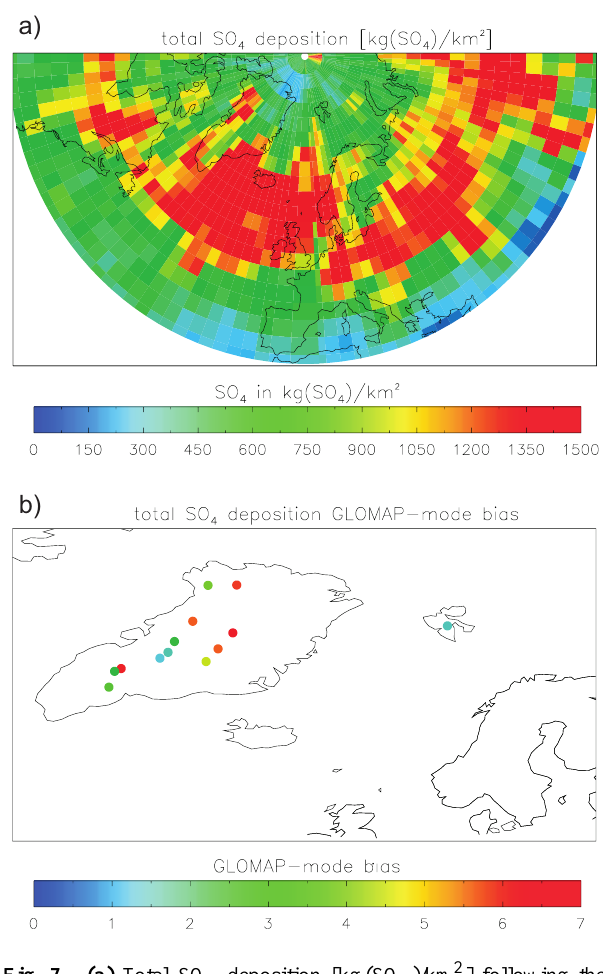
Fig. 7. (a) Total SO 4 deposition [kg(SO 4 )/km 2 ] following the first 12 months after the onset of the Laki eruption shown for the Northern Hemisphere. (b) Bias of modelled total SO 4 deposition [kg(SO 4 )/km 2 ] when compared to ice core measurements in Green- land (Mosley-Thompson et al., 2003; Clausen and Hammer, 1988, Table V) and Svalbard (Kekonen et al.,